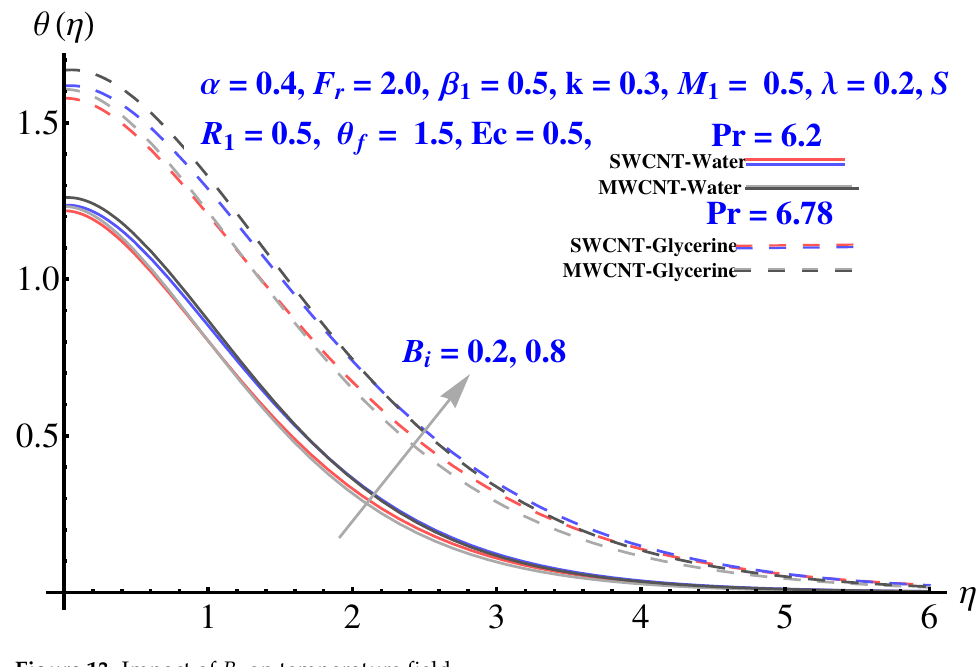
Figure 13. Impact of B i on temperature field.